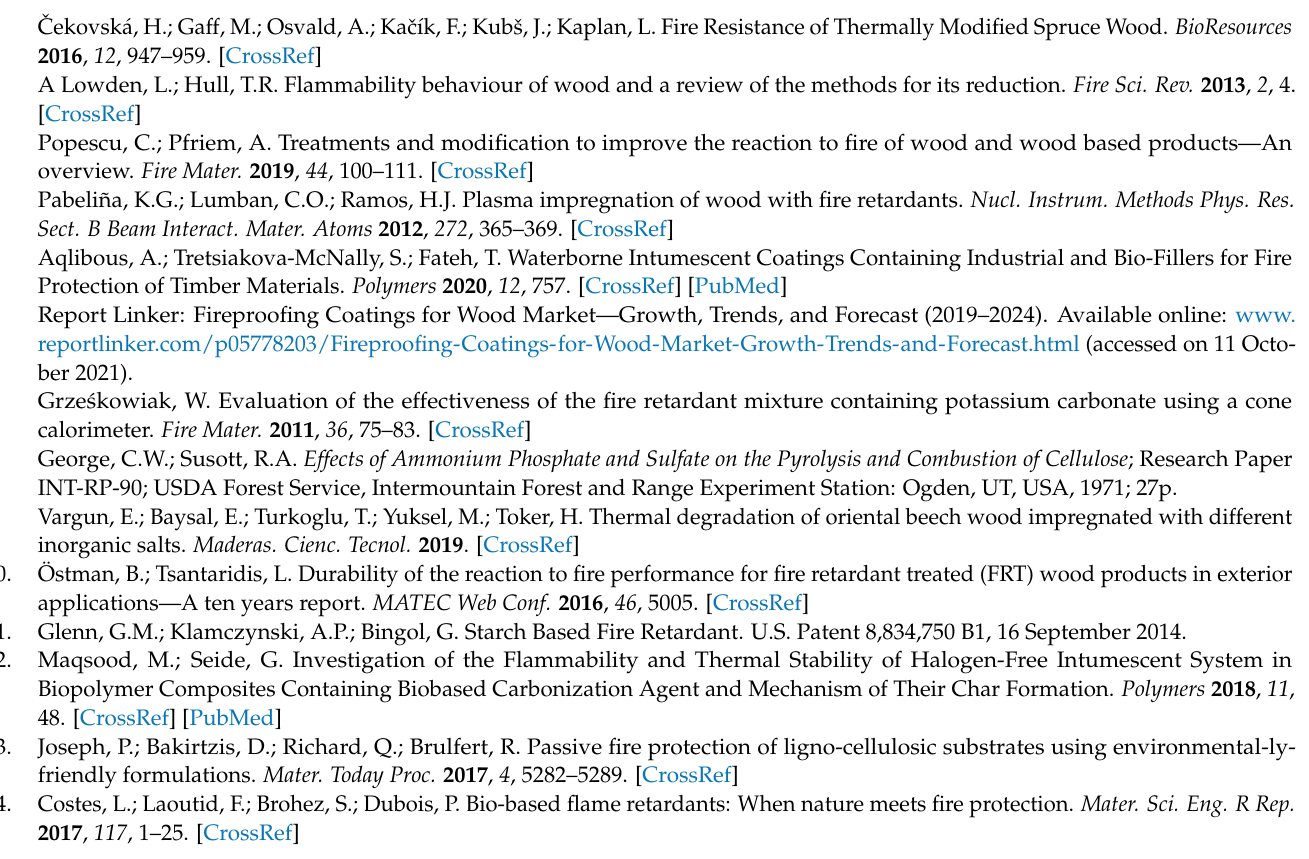
formulations, Figure S3: The snapshots taken from the videos recorded during cone calorimetry testing, 10 s after the ignition: (a) untreated wood; (b) wood coated with ‘starch + K 2 CO 3 ’ formulation, Figure S4: FT-IR spectra of gaseous products produced in the tube furnace during decomposition of untreated wood (black) and wood coated with ‘starch + K 2 CO 3 ’ formulation (green), 350 ◦ C, nitrogen atmosphere (the abscissa is wavenumber (in cm − 1 ) and the ordinate is absorbance (in arbitrary units, Figure S5: FT-IR spectra of gaseous products produced in the tube furnace during decomposition of untreated wood (black) and wood coated with ‘starch + K 2 CO 3 ’ formulation (yellow), 650 ◦ C, nitrogen atmosphere (the abscissa is wavenumber (in cm − 1 ) and the ordinate is absorbance (in arbitrary units), Table S1: The onset temperature (T onset ) of the main degradation step, and char residues at 800 o C measured trough TGA in nitrogen and in air